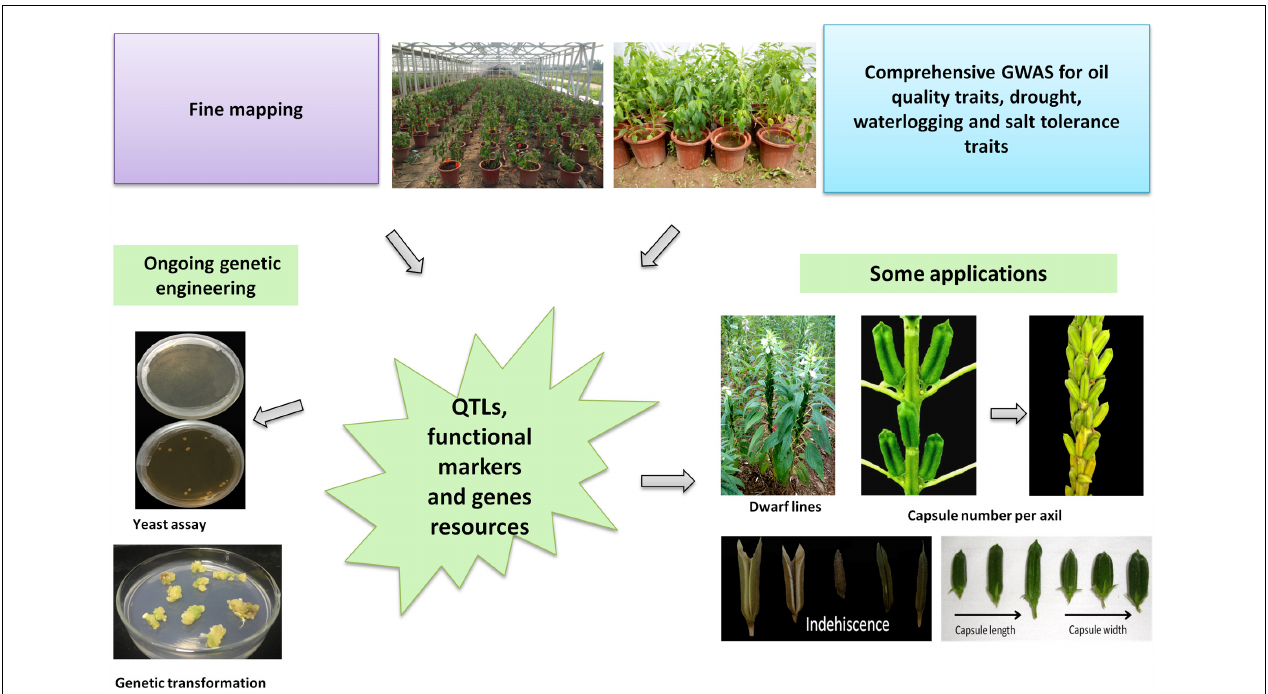
FIGURE 4 | Deployment of newly developed “Omics” tools in sesame improvement